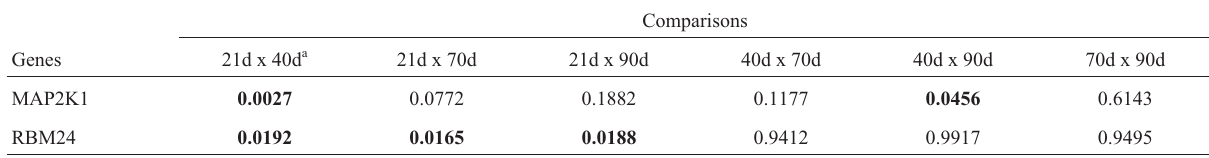
a 21d, 40d, 70d and 90d indicate the prenatal ages. Values in bold were statistically significant (p < 0.05).